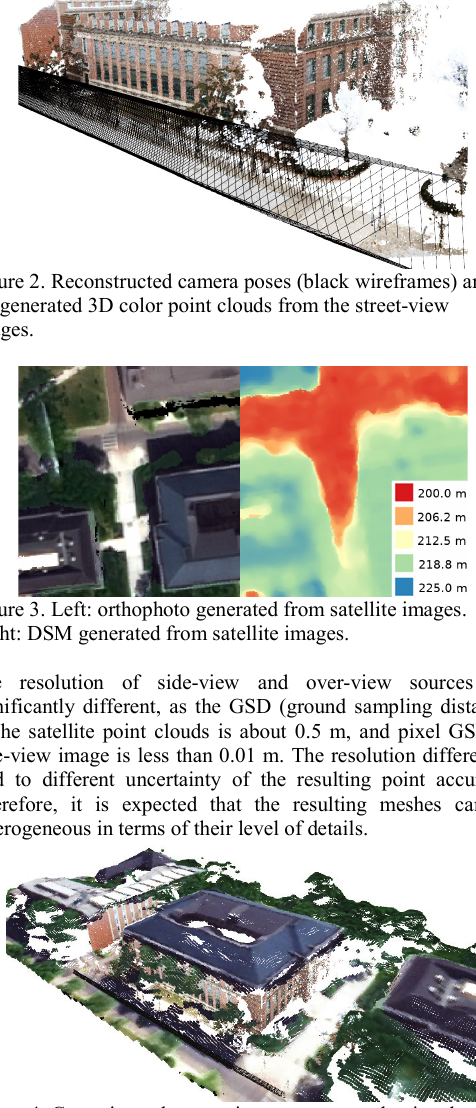
Figure 4. Co-registered street-view reconstructed point clouds and satellite reconstructed point